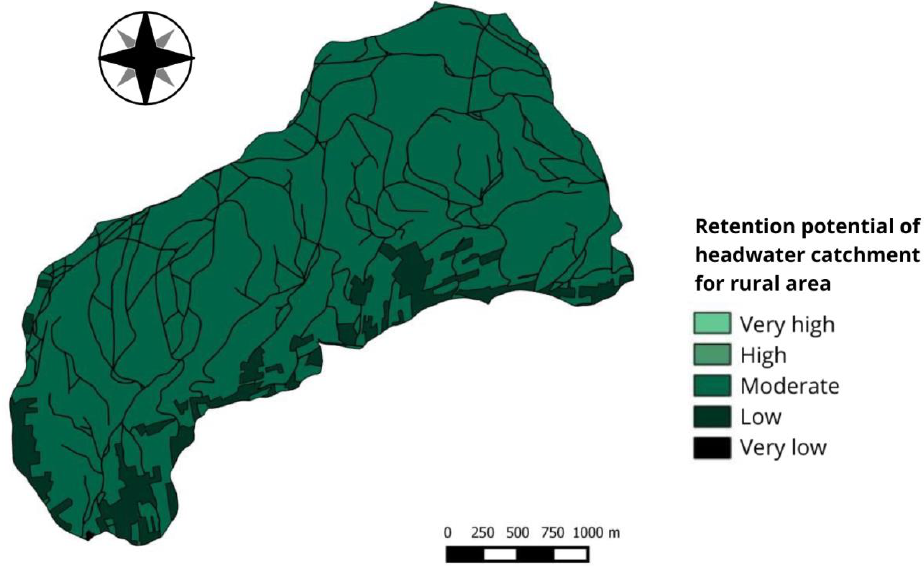
Figure 11. Retention potential of headwater catchment for rural area.